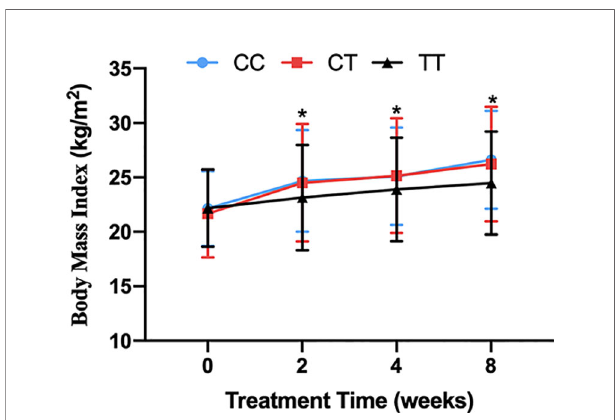
FIGURE 1 | The BMI of carriers with CC, CT and TT genotypes of MTHFR C677T polymorphism during the 8-week risperidone treatment. There was no signi fi cant difference in BMI of three genotype carriers before risperidone treatment. However, the BMI of carriers with three genotypes of MTHFR gene increased over 2 – 8 weeks. After 2, 4, and 8 weeks of risperidone treatment, BMI added value of CC or CT genotype carriers was signi fi cantly higher than that of TT genotype carriers. Asterisks indicate that there are signi fi cant differences among BMI of CC, CT, and TT genotype